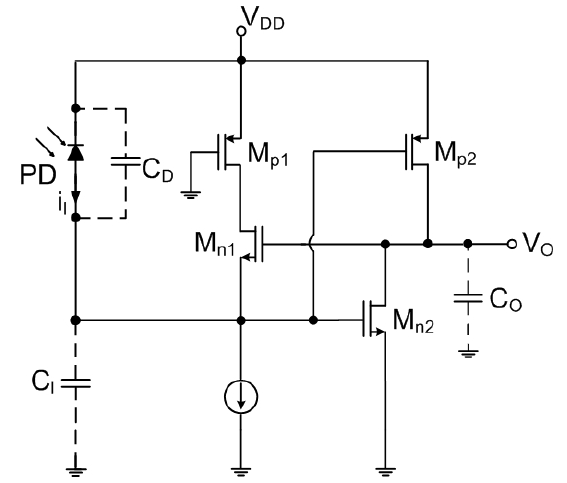
Figure 12. An inverter with active common-drain feedback (ICDF)